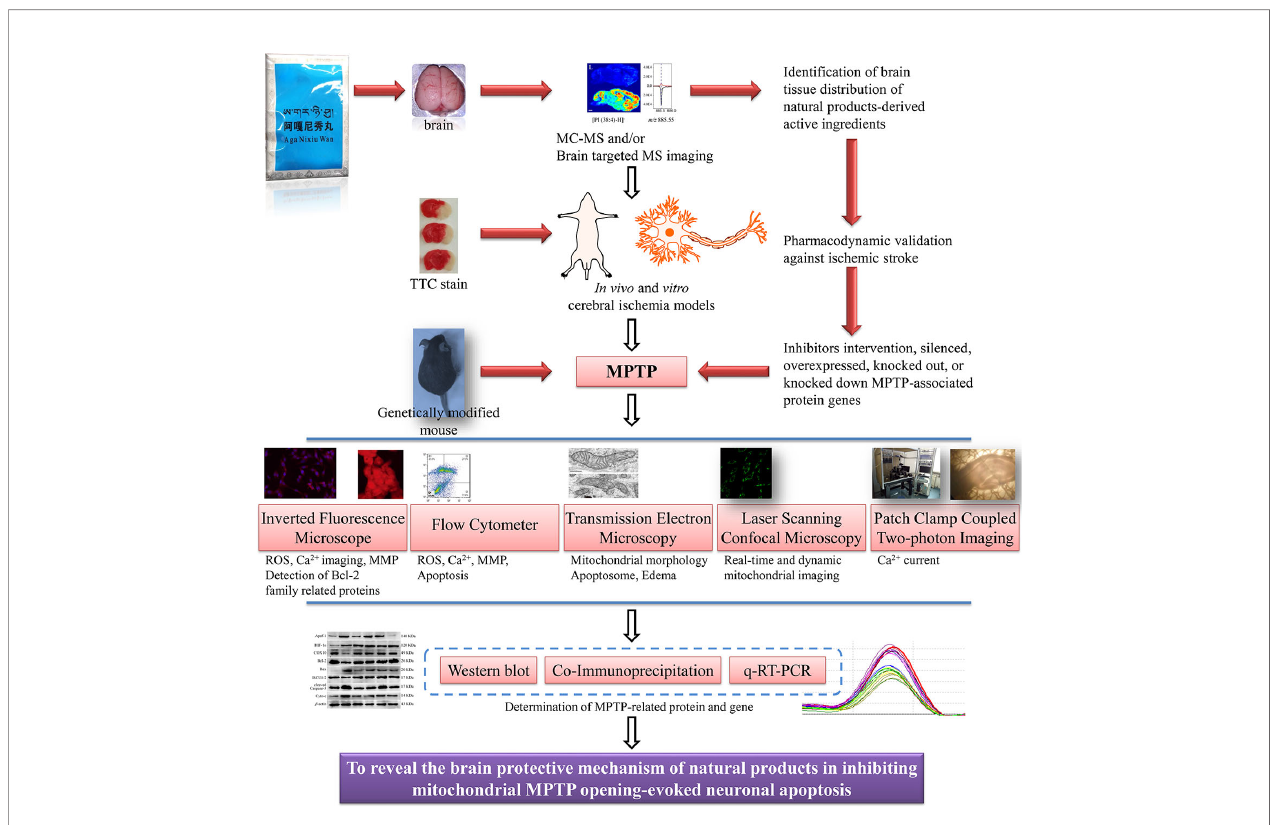
FIGURE 5 | Conceptual fl owchart of combined multiple techniques for MPTP regulation by natural products on apoptosis of ischemic neurons. Mitochondrial MPTP is a novel target for the treatment of ischemic stroke. Determination of the distribution of natural products in distinct brain regions, reasonable in vivo and in vitro stroke models, and advanced MPTP imaging technologies will be conducive to the development of ethnic drugs targeting